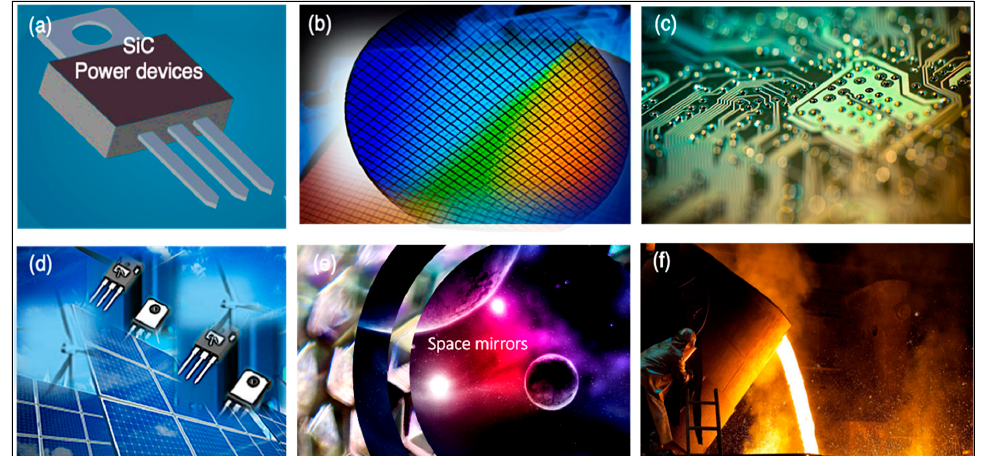
Figure 1. An overview of SiC applications: Examples include: ( a ) power semiconductor devices; ( b ) wafers; ( c ) integrated circuits; ( d ) renewable energies; ( e ) space mirrors; ( f ) high-temperature applications. SiC materials have also been used widely for quantum technologies, nuclear energy, aviation, abrasives, and several structural